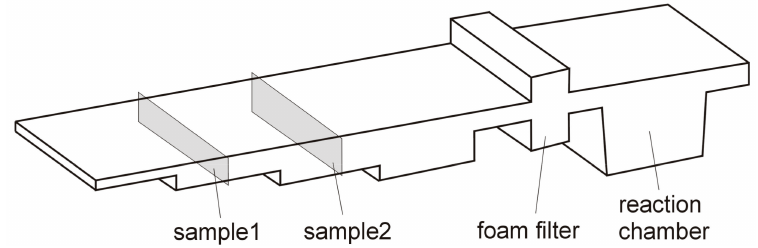
Figure 2. Scheme of location where the metallographic samples was collected.